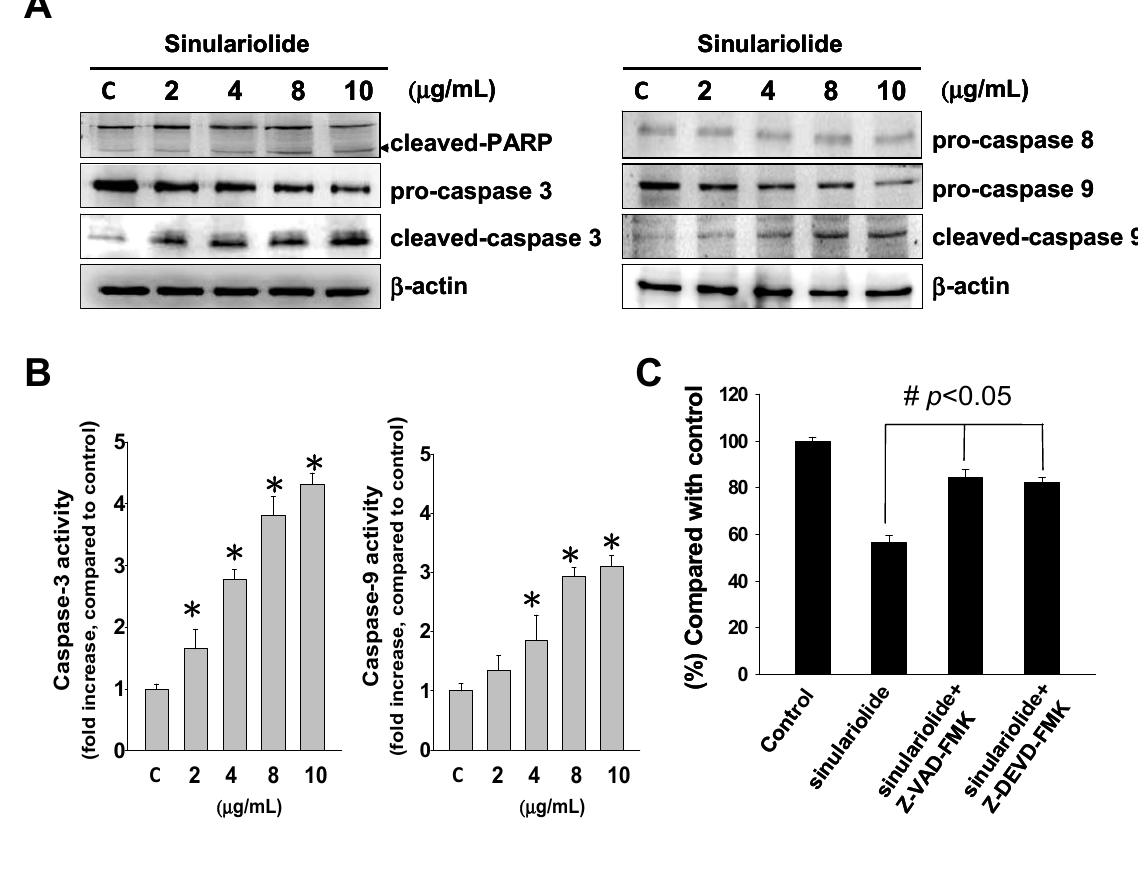
Figure 3. Sinulariolide induced apoptosis through activated caspase cascade